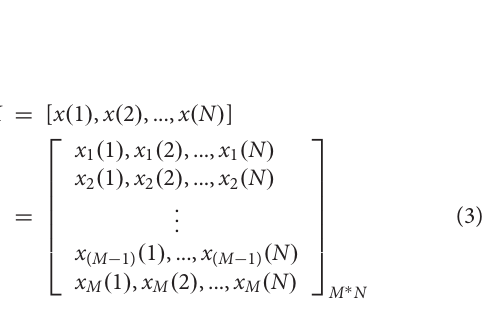
FIGURE 5 | Comparison of uniform and maximum entropy partitioning in spherical partitioning and symbol sequence generation